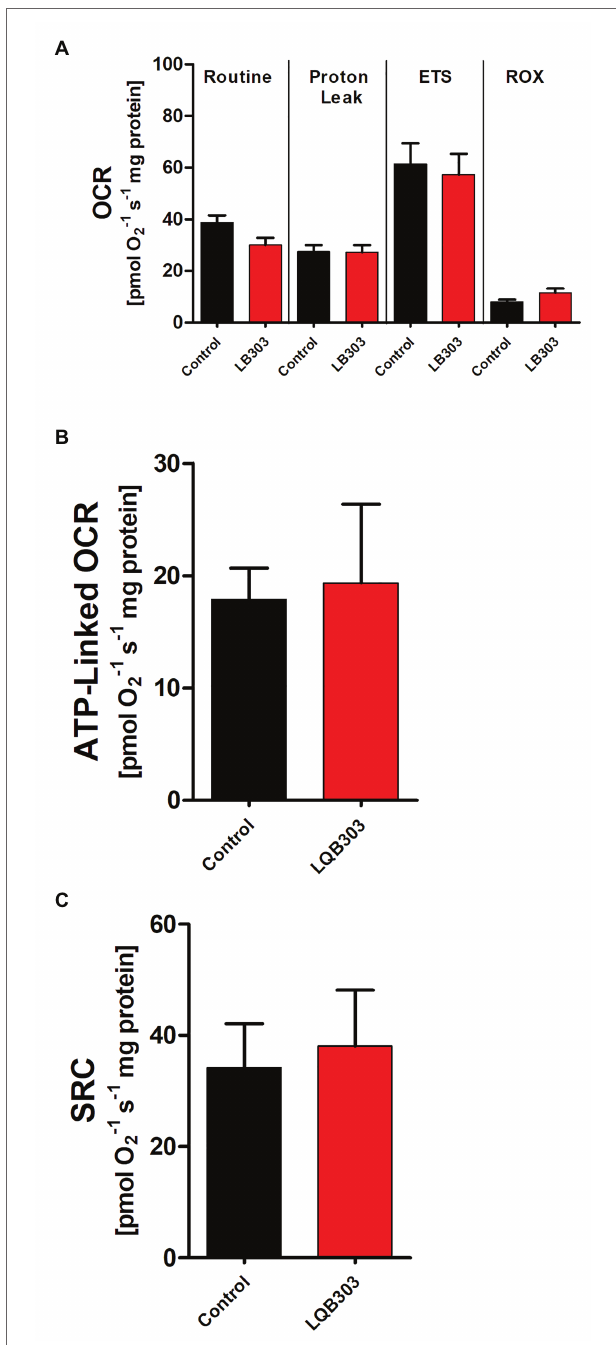
FIGURE 3 | Effect of LQB303 on oxygen consumption rates of non-infected Vero. (A) Non-infected VERO cells were cultured in RPMI medium supplemented with 10% FCS and were incubated in the presence or absence of 6 μ M LQB303 for 48 h and were assessed by high resolution respirometry. The cells were subjected to 2 μ g/ml oligomycin, increasing concentrations of FCCP up to 3 μ M, 0.5 μ M Rotenone, and 2 μ g/ml AA. (B) ATP-linked OCR was calculated by subtracting routine oxygen consumption rates after adding oligomycin. (C) The spare respiratory capacity was calculated by subtracting the routine from the ETS. All data are presented as average ± SE of five independent experiments, performed in duplicate. There was no statistical difference when compared to the control group by Student’s t